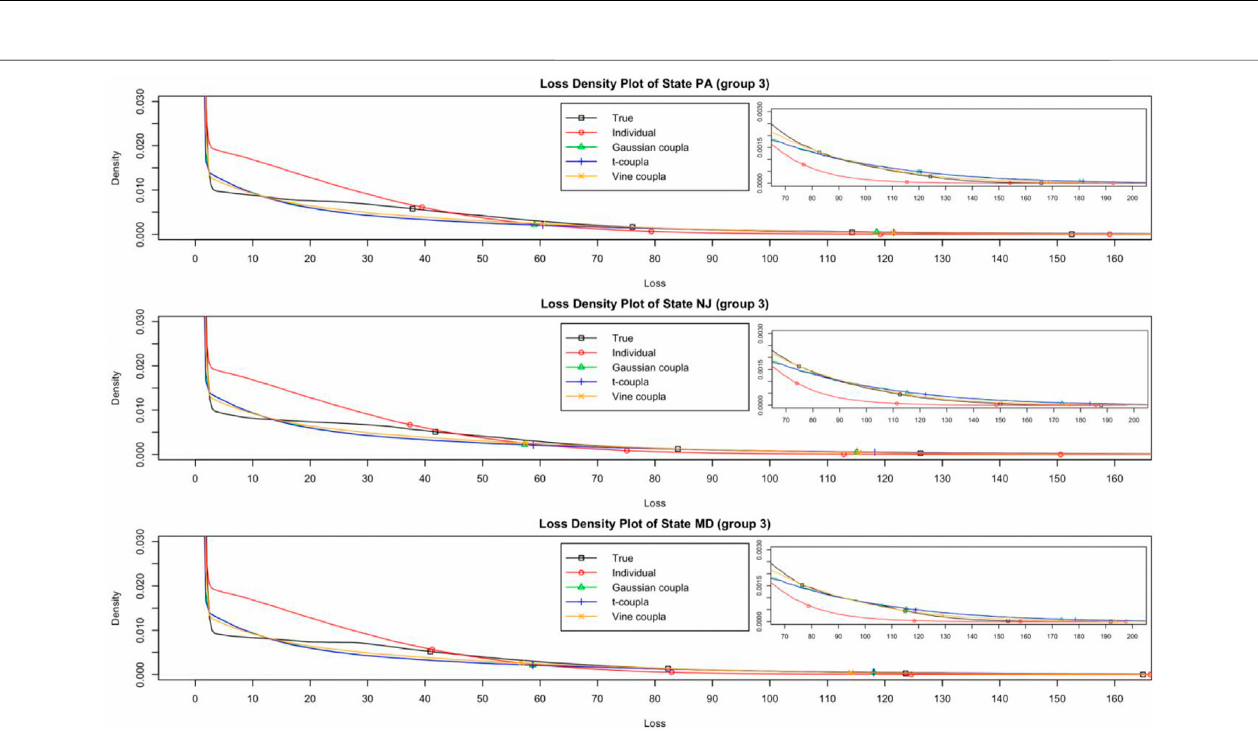
FIGURE 4 | The losses density plot for states in Group 3 (Weibull distribution with a duration of 30 years).